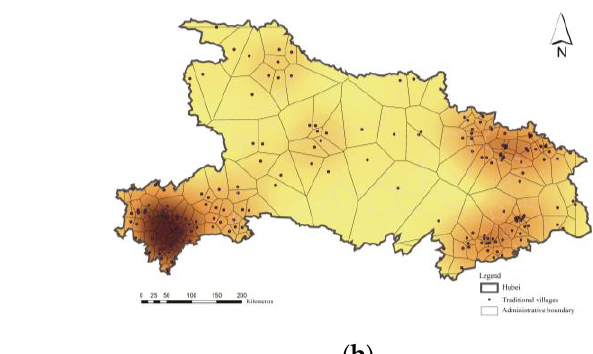
Figure 3. ( a ) Kernel density distribution of traditional villages; ( b ) Voronoi diagram of traditional villages.